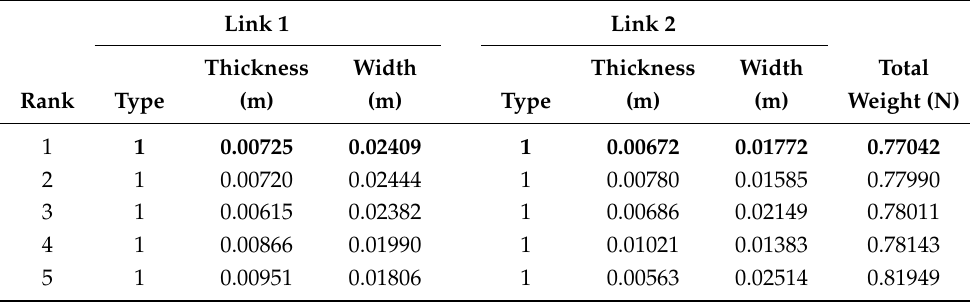
Table 3. First five best solutions of ImHS.